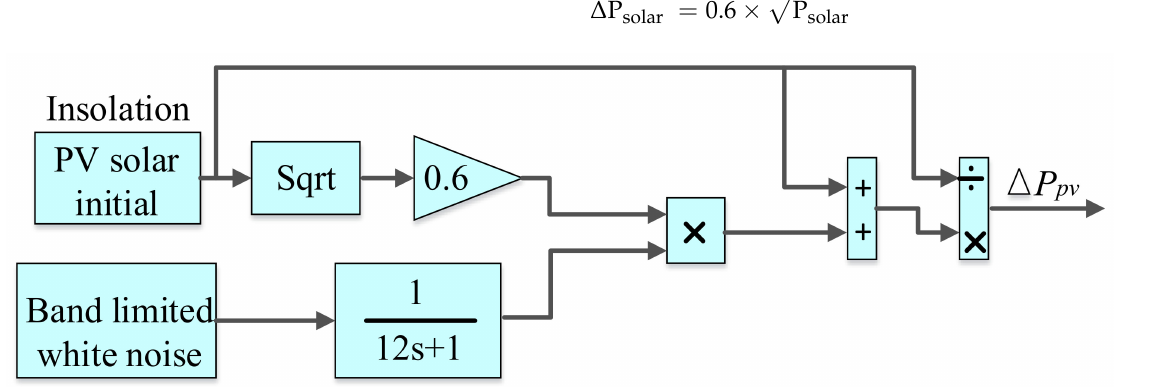
Figure 5. The implemented model of the solar power plant using MATLAB/Simulink (R2015a) program.